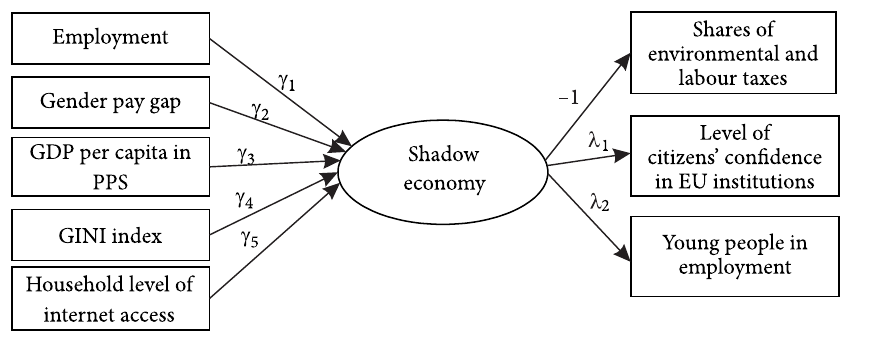
Figure 2. Development of the MIMIC 5-1-3 model for the Eurozone member